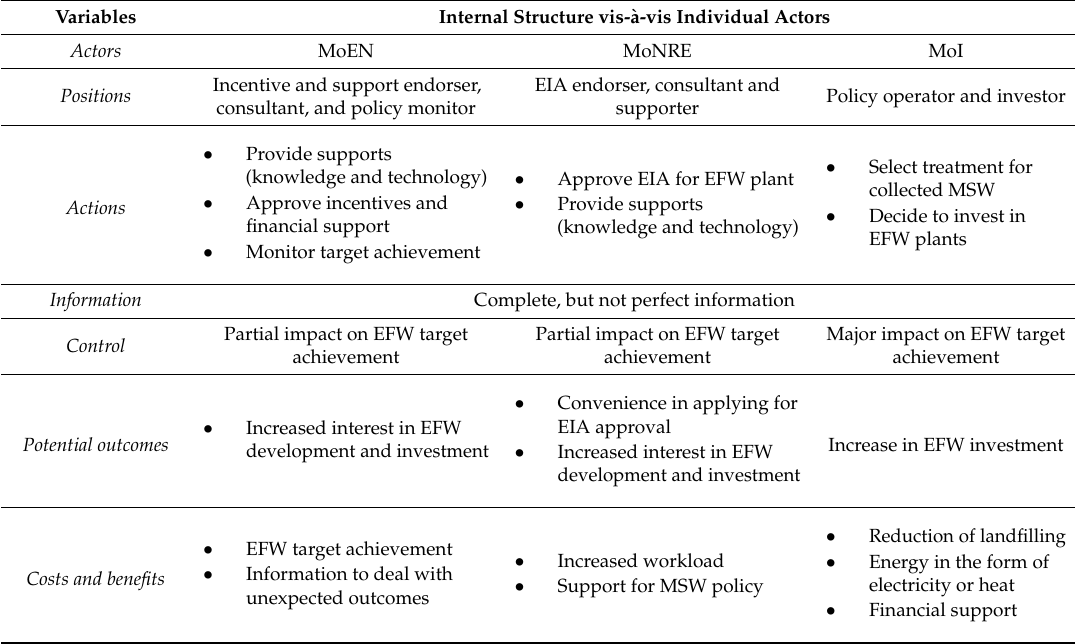
Table 6. Internal structure of policy implementation situation on the basis of actors.